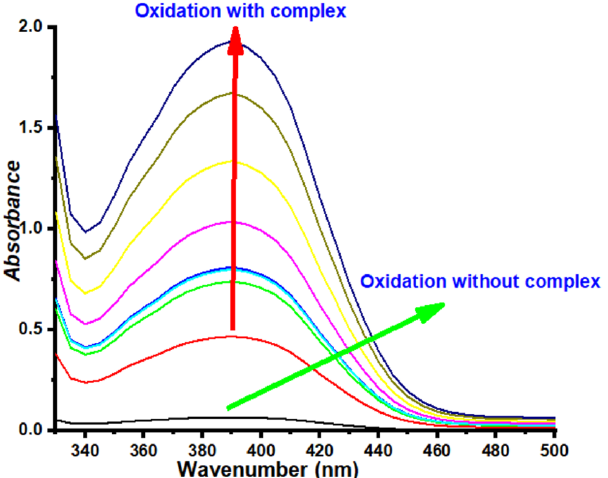
Figure 2. Absorbance spectrum of o -quinone as a function of time for the combination Figure 1. Absorbance spectrum of o -quinone as a function of time for the combination L 2 /Cu(CH 3 COO) 2. L 2 /Cu(CH 3 COO) 2